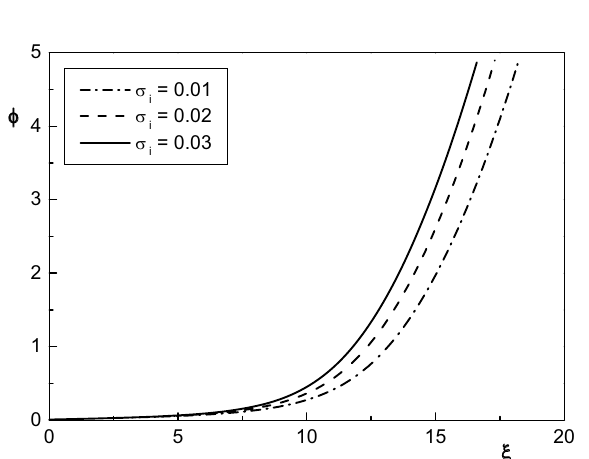
Figure 9. Spatial distribution of the normalized density of positive ions and negatively charged particles for κ c = 2.4 , δ b = 0.005 and different values of σ i . The other parameters are the same with Fig. 5.